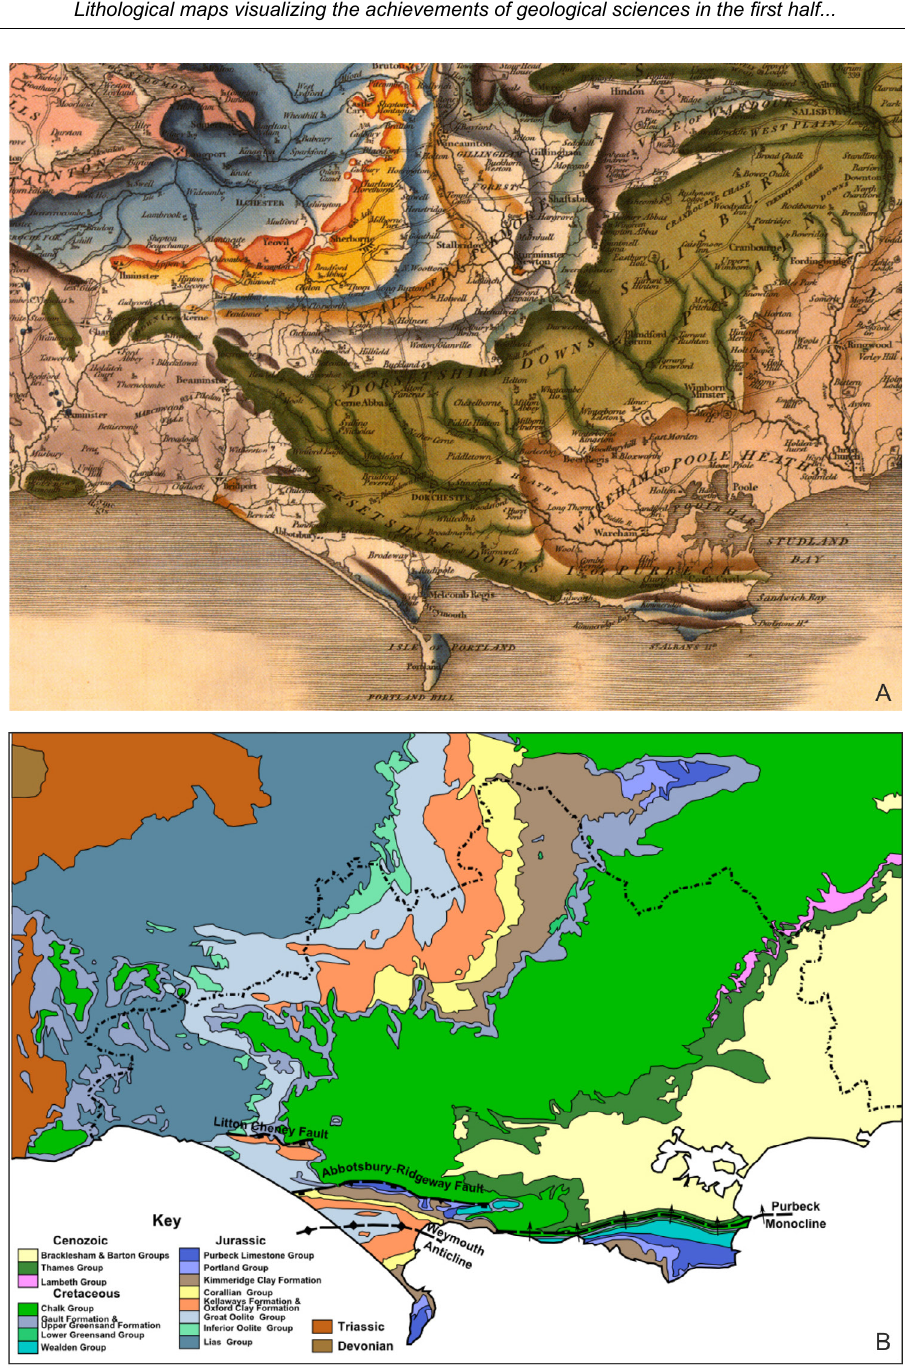
Fig. 5. Presentation of the geology of Dorset County on the part of: A − the W. Smith’s map of 1815 (from the collection of the Princeton University Library) and B − the M. Norton’s map Dorset Geology created on 22 July 2012, https://en.wikipedia.org/wiki/Dorset (access